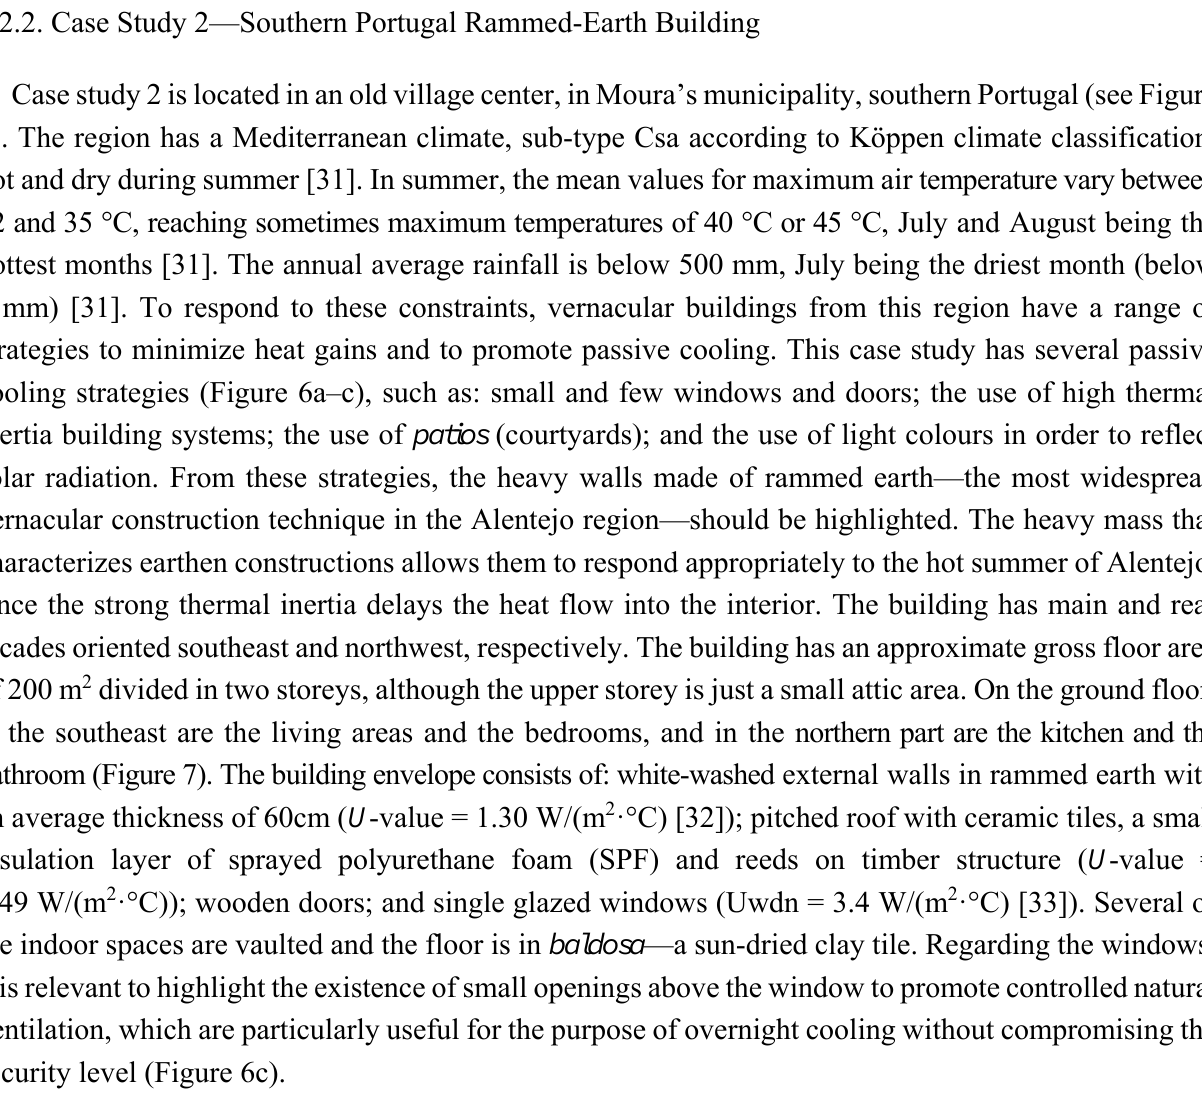
Figure 5. Floor plans (1—living room / kitchen; 2—bedroom; 3—bedroom with balcony;